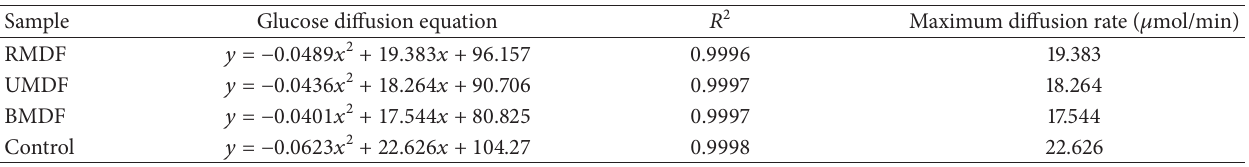
Table 3: Glucose diffusion equation with different IDF